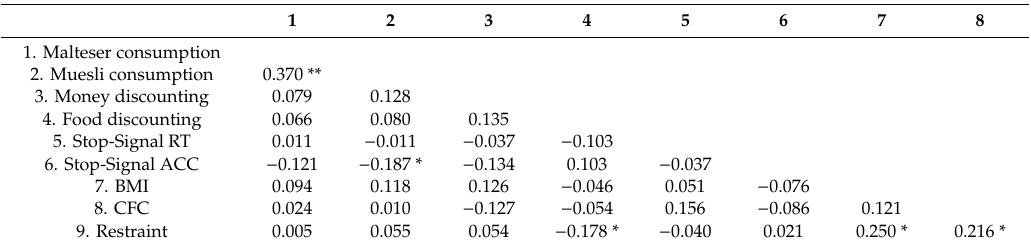
Table 4. Correlations coe ffi cients between variables in Experiment 2.